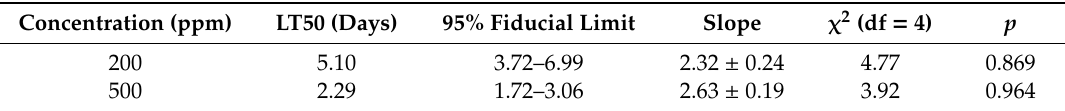
Table 3. Median lethal time (LT 50 ) values of Beauveria brongniartii Fe 0 NPs nanoparticles against Spodoptera litura estimated by probit